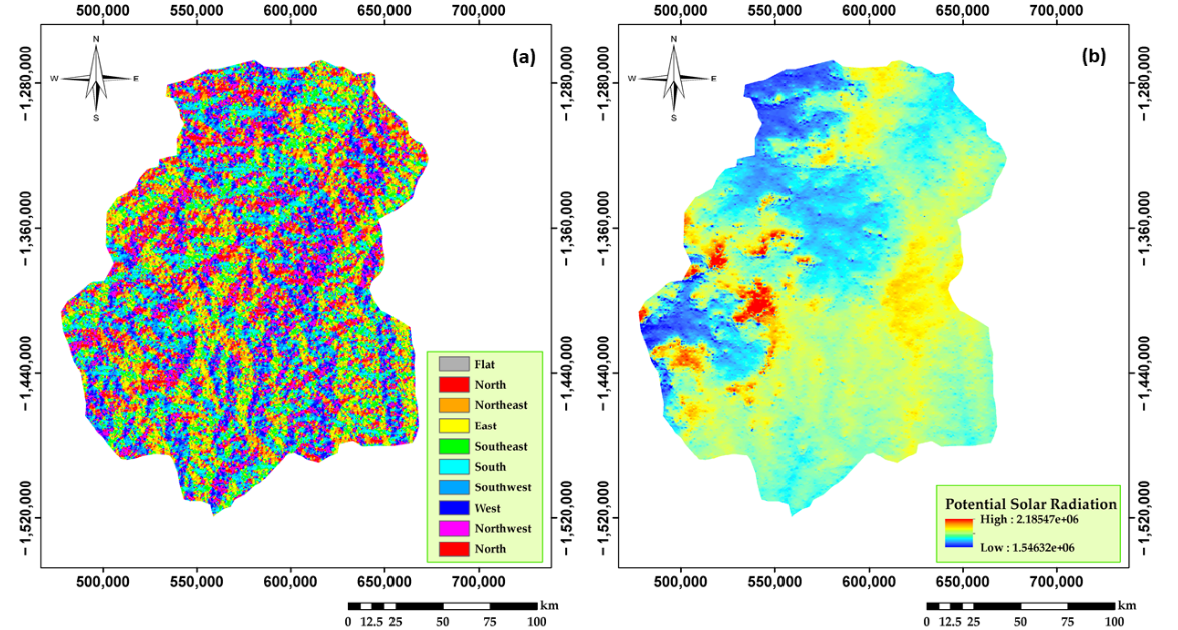
Figure 5. ( a ) Aspect values are classified into 10 different classes, which indicate the directions of the physical slope face and ( b ) potential solar radiation across the entire study area.